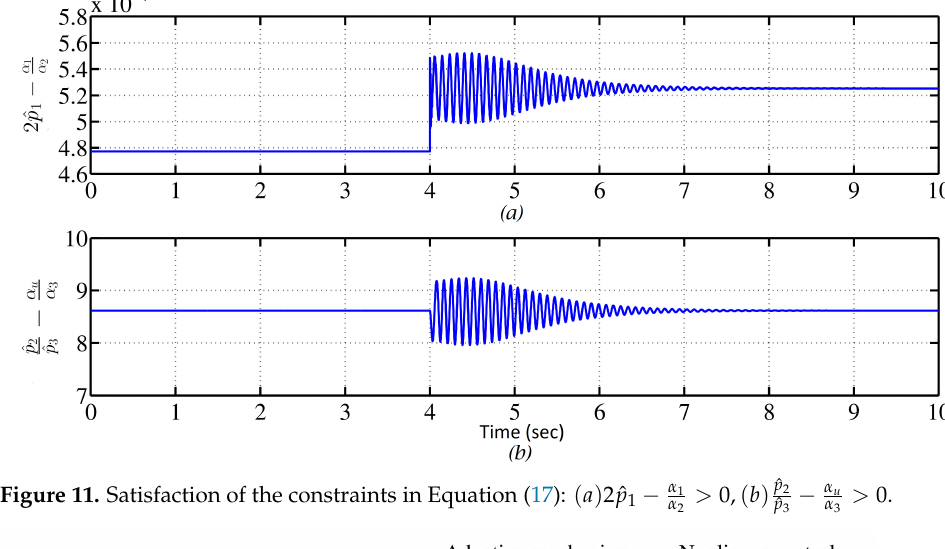
> 0, ( b ) ˆ p 2 − α u > 0. ˆ p 3 α 2 α 3